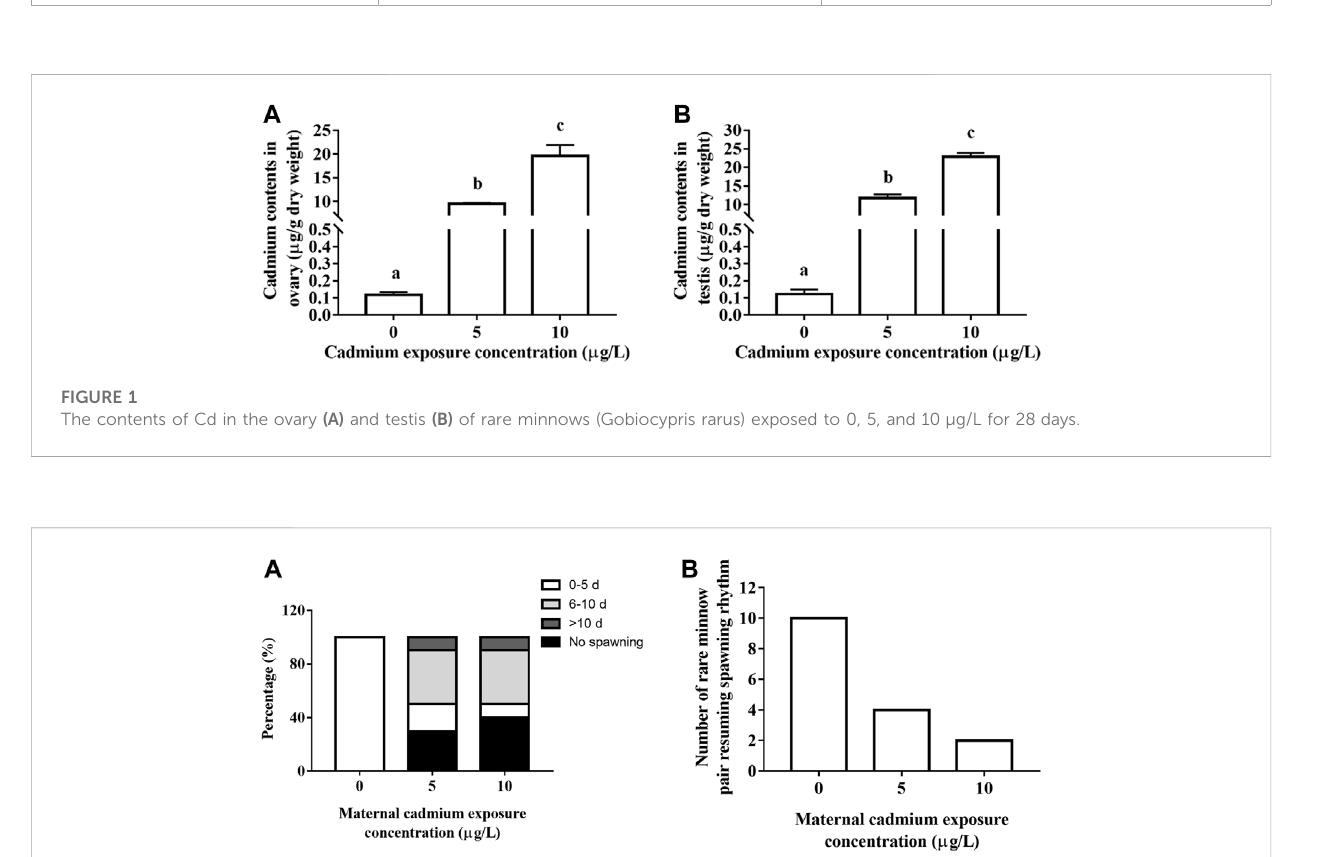
FIGURE 2 Frequency distribution of fi rst spawning events (A) and resuming spawning rhythm (B) of rare minnow ( Gobiocypris rarus ) after Cd exposure following a 28 days reproduction period.